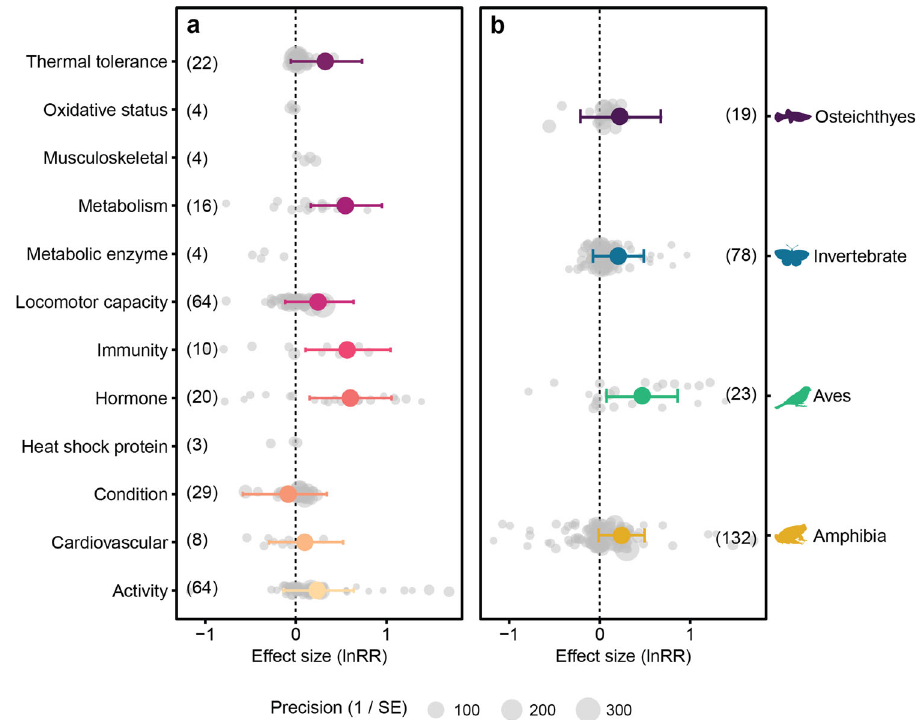
Fig. 6 Differences in physiological traits between population core range and dispersal front. a Effect sizes showing differences between the range core and edge in physiological traits across all taxa, and b overall effect of all (lumped) physiological traits on different taxonomic groups. Only traits or taxa with more than fi ve effect sizes were analysed. Positive direction indicates populations at the range edge have higher physiological capacity. Numbers in brackets indicate the effect size for each categorised trait or taxon. Grey points represent individual effect sizes, and the symbol size of each individual effect size corresponds to study precision (inverse of standard error). Effect sizes (lnRR) are estimates ±95% credible